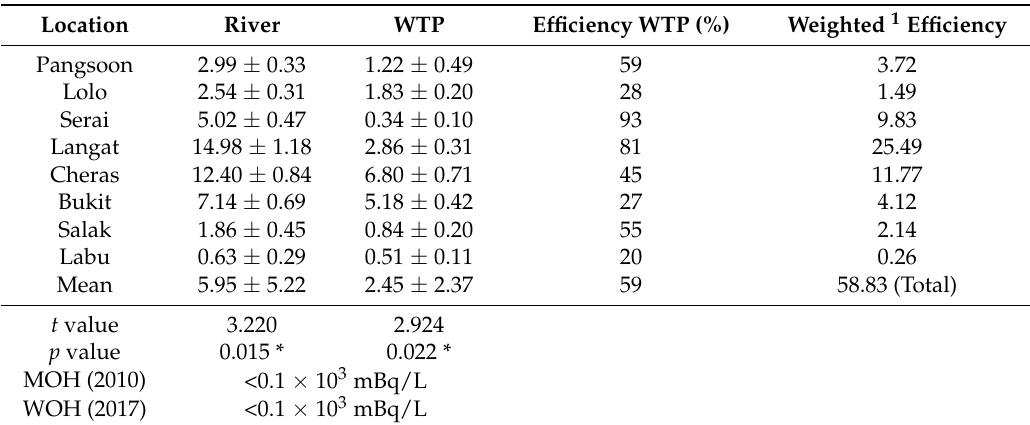
Table 3. Po-210 activity (mBq/L) in raw and treated water at the Langat River Basin. Location